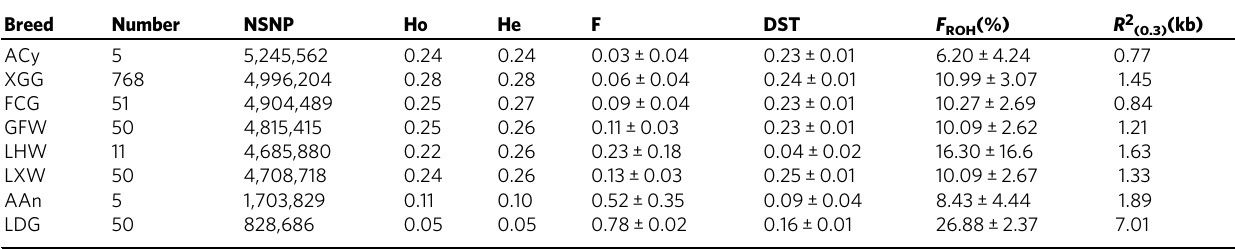
Table 2 Genetic diversity among eight geese